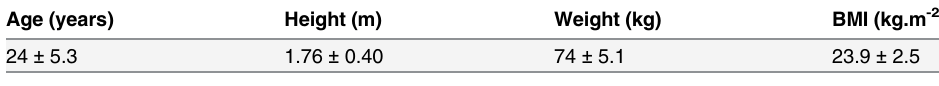
Table 1. Subject characteristics: BMI: body mass index. Values are given as mean and